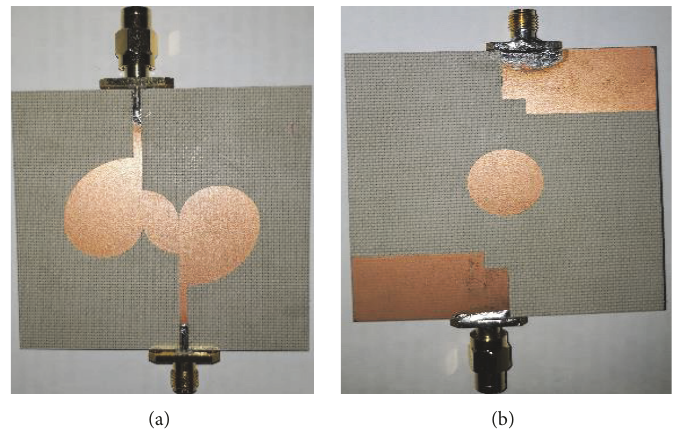
Figure 7: Fabricated UWB MIMO Antenna: (a) Top view, (b) bottom view.